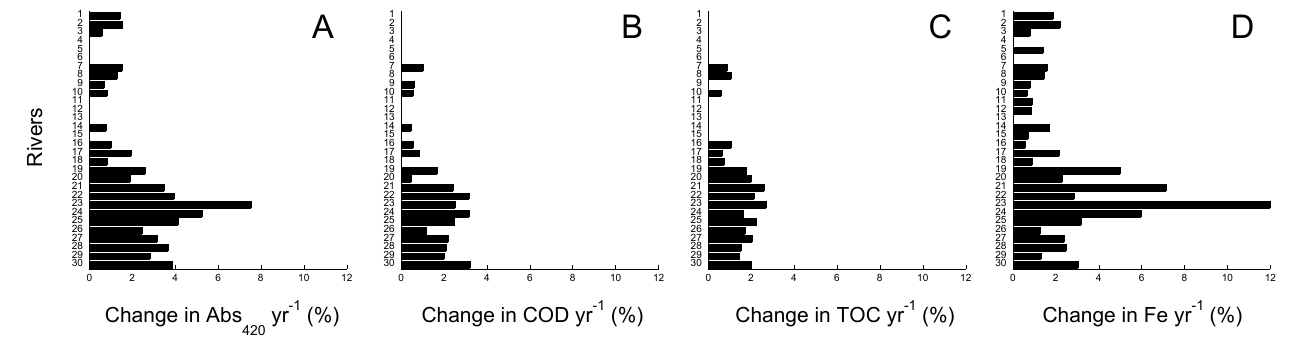
Fig. 2. The rate of change per year of Abs 420 , COD, TOC and Fe. For Abs 420 , COD and Fe it is the change between 1972 and 2010. For TOC it is the change between 1987 and 2010. Where there are no bars there is no significant change over time.